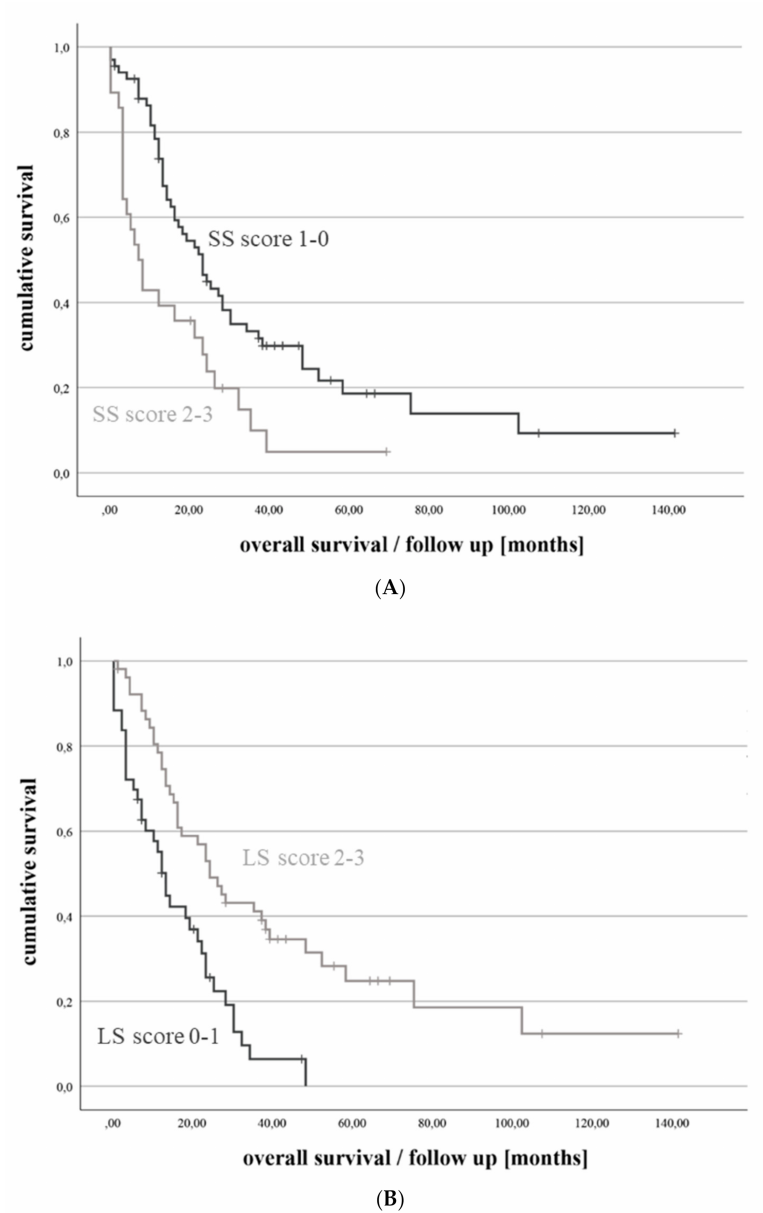
Figure 2. Kaplan–Meier curves demonstrate the survival differences in BCBM patients with low (0-1 points) and high (2–3 points) score value: ( A ) SS-scores (log rank test p = 0.002). ( B ) LS-scores (log rank test p <